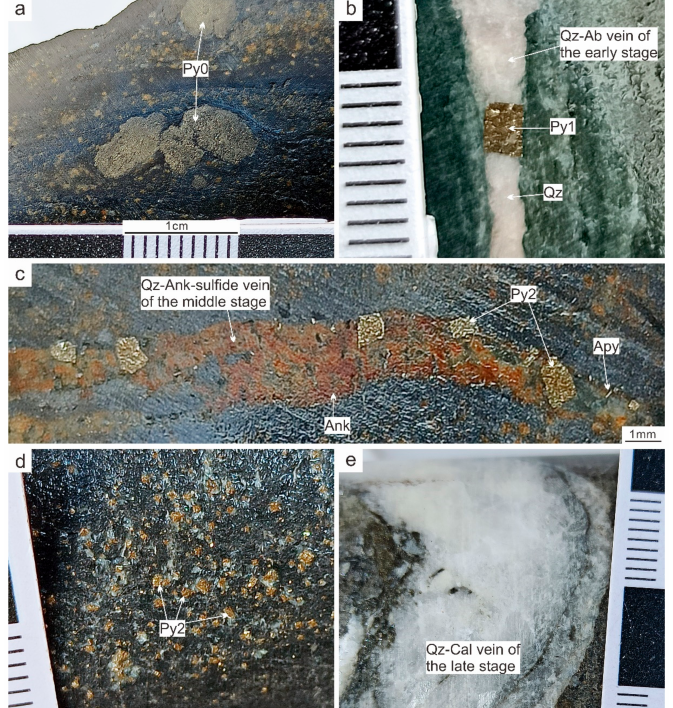
Figure 4. Photographs of hand specimens showing mineralization characteristics at different stages in the Dunbasitao gold deposit. ( a ) Sedimentary pyrite nodules of Py0 hosted in the Jiangbasitao Formation with the bedding around them significantly curved. ( b ) A quartz–albite vein in the early stage with a coarse-grained cubic Py1 in it. ( c ) A quartz–ankerite–sulfide vein in the middle stage with fine-grained Py2 and arsenopyrite in it. ( d ) Disseminated, anhedral Py2 in host rocks. ( e ) A quartz–calcite vein in the late stage without sulfides. Qz—quartz; Ab—albite; Ank—ankerite; Cal—calcite; Py—pyrite;